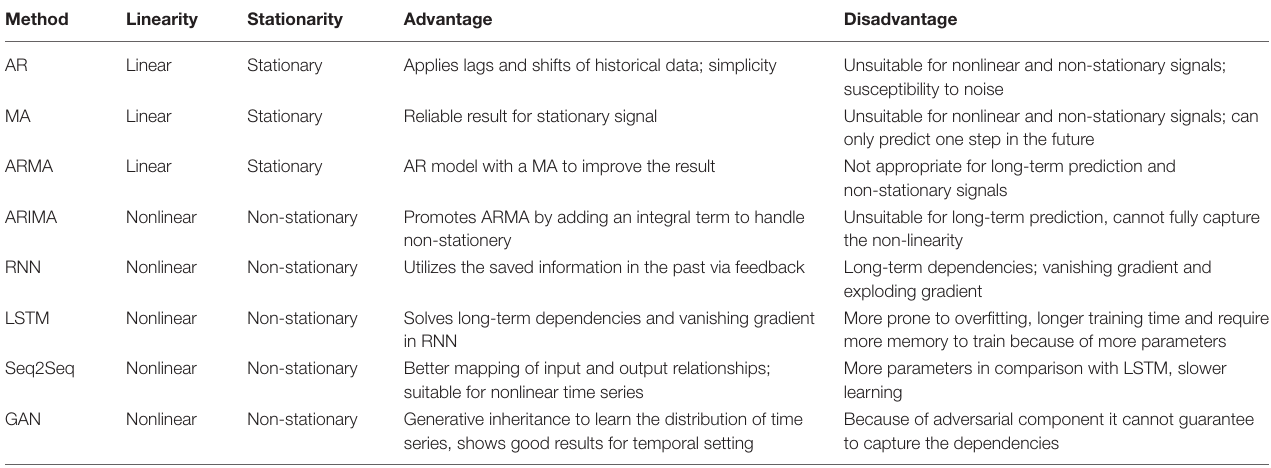
TABLE 1 | Comparison of the selected methods reviewed in this paper.